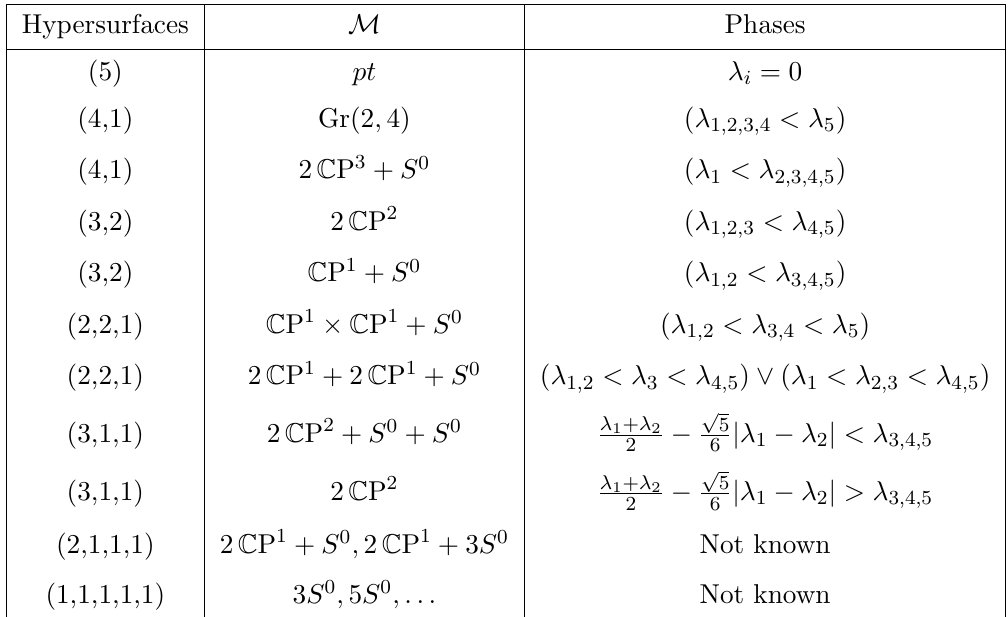
= 1 SU(5) WZ Model. N